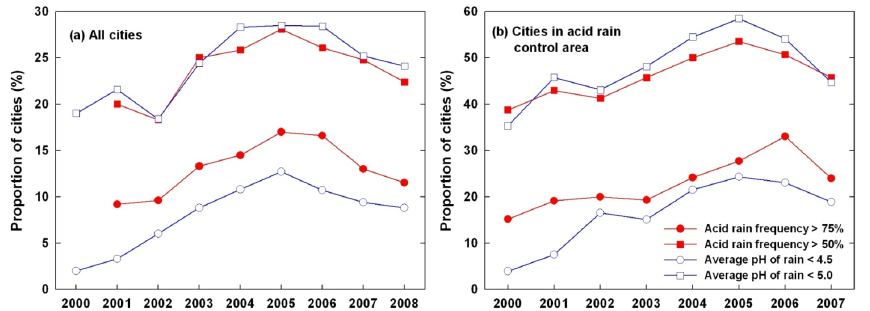
Fig. 8. Proportion of cities with acid rain frequencies above 50% and 75%, and with average pH values of precipitation below 5.0 and 4.5 in China. (a) All cities under the National Acid Rain Monitoring Program. (b) Cities in the acid rain control